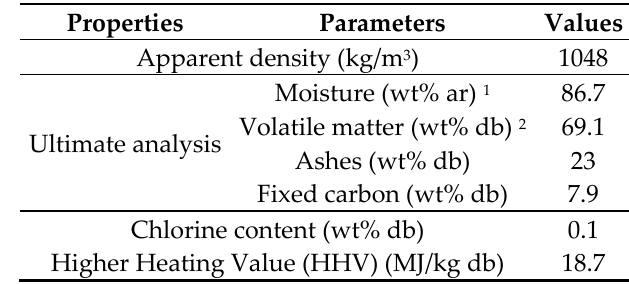
Table 1. Characterization of the sludge from the wastewater treatment plant.